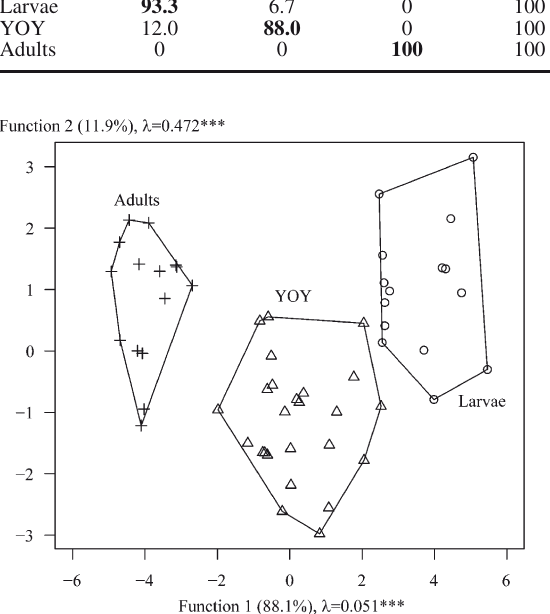
Fig . 4. – Plot of the CDA carried out with multi-element fingerprints of life stages otolith signatures for all sites grouped: (o) larvae, young of the year (YOY, Δ ), adults (+) for all sites grouped. Results of cross-validation in percentage are shown in Table 6.